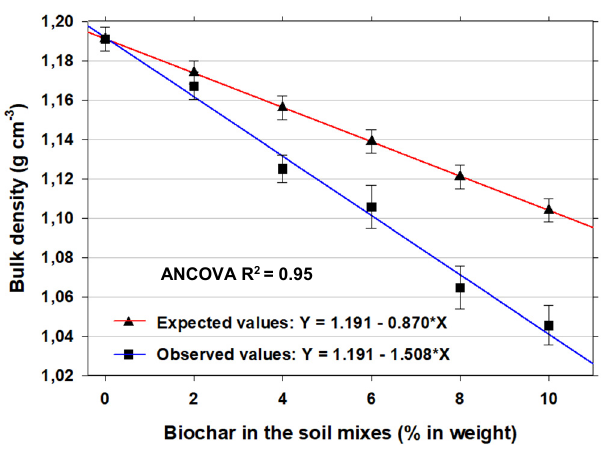
Figure 3. Linear regression of bulk density (g cm − 3 ) against increasing fractions (%) of biochar in the soil to obtain the experimental soil–biochar mixtures. Red line represents the expected trend based on a simple “dilution” effect, while the blue line regressed the observed data as experimentally observed. The slopes of the two lines are significantly different according to the ANCOVA results. Vertical bars are standard errors.